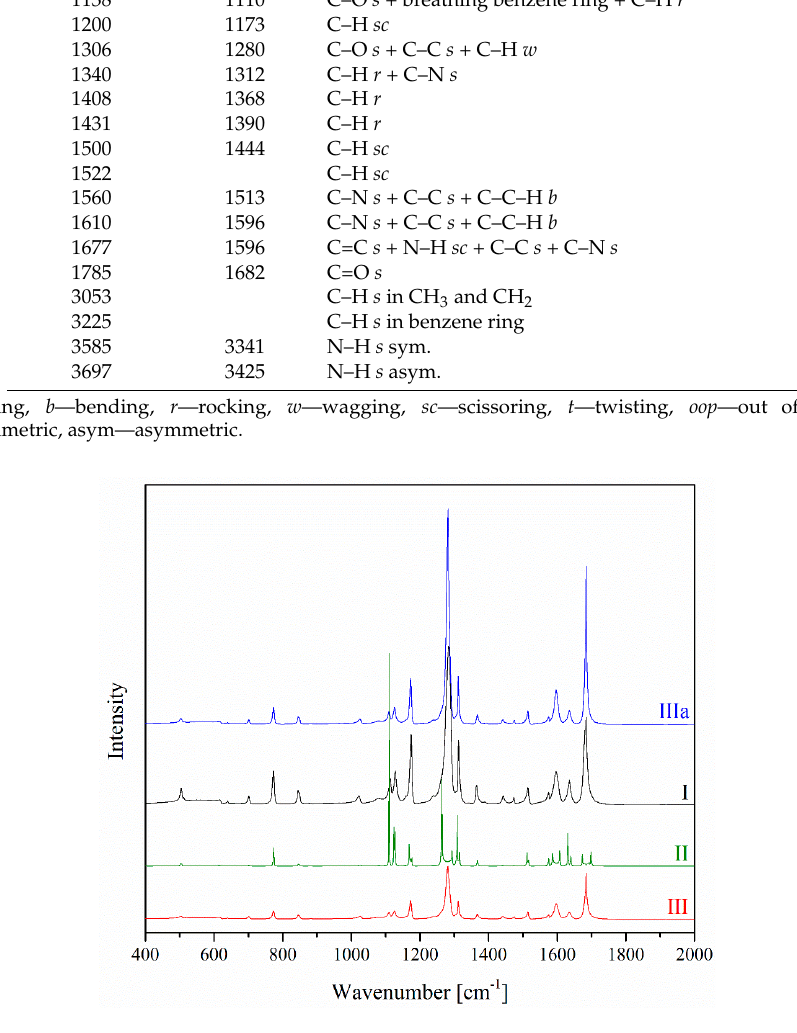
Figure 2. FT–IR spectra of polymorphic forms of benzocaine.